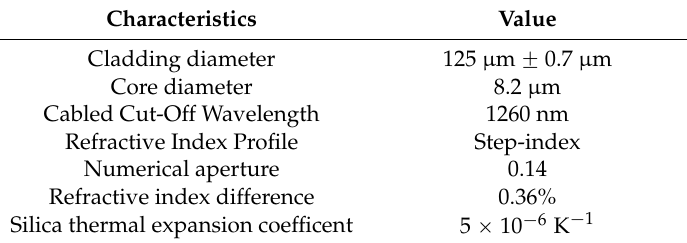
Figure 8. Optical setup. Table 1. G.652D optical fiber characteristics and silica properties.